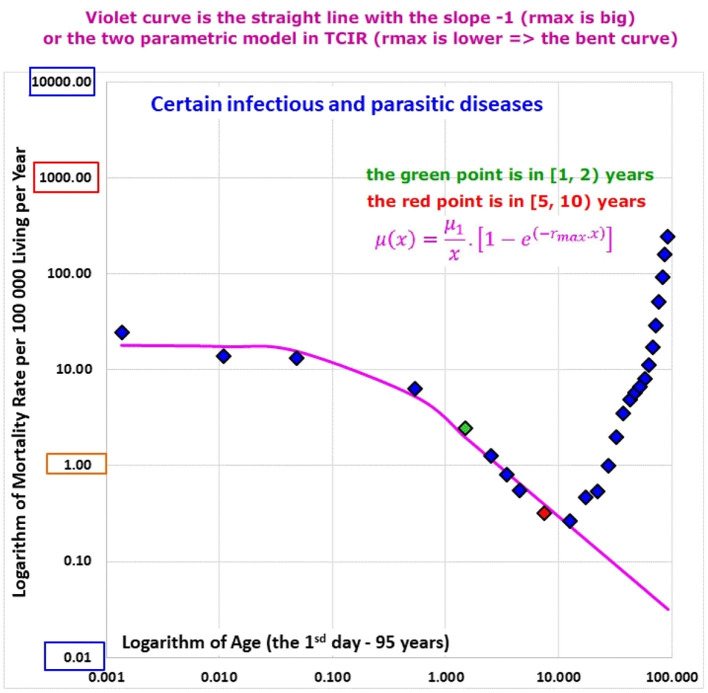
(Animation 2) Certain infectious and parasitic diseases in P14.